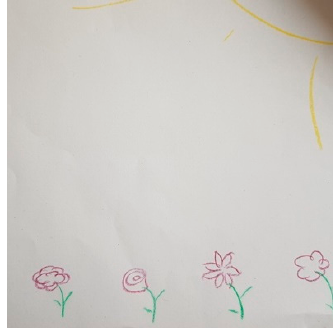
Figure 12. FC41’s perception of DBS’s effect.